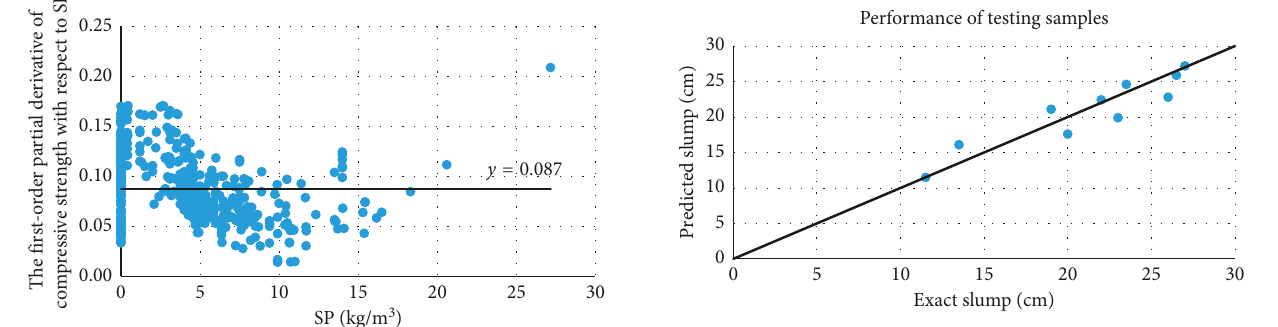
Figure 10: Distribution of SP and the first-order partial derivative of compressive strength with respect to SP for the training samples of the CSPNN.